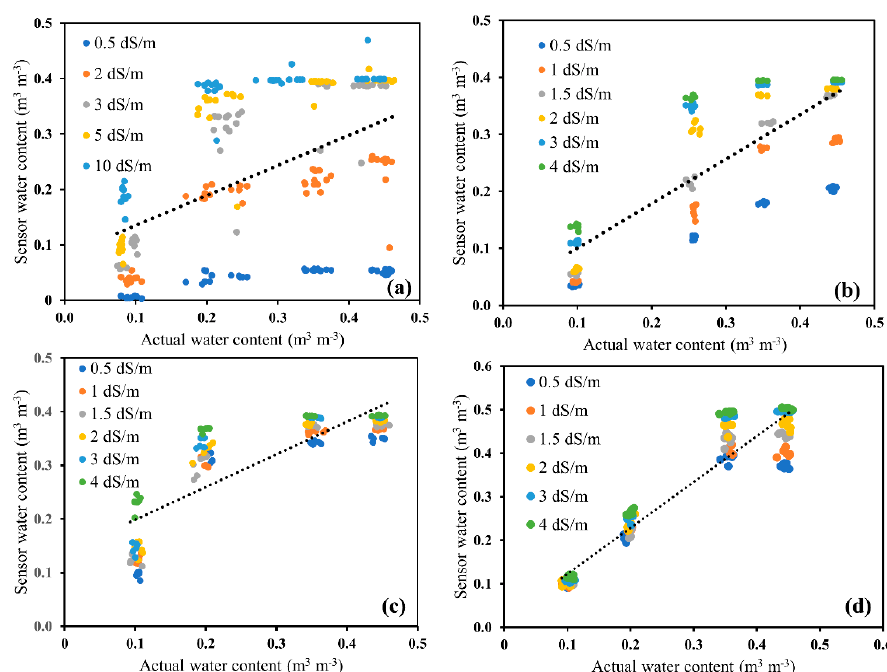
Figure 4. Comparison of combined sensor water content with gravimetrically-determined actual water content for ( a ) glass beads, ( b ) Oso Flaco sand, ( c ) Columbia loam, and ( d ) Yolo clay loam over a range of water and electrical conductivity solutions. Sensors 2020 , 20 , x FOR PEER REVIEW 10 of 14